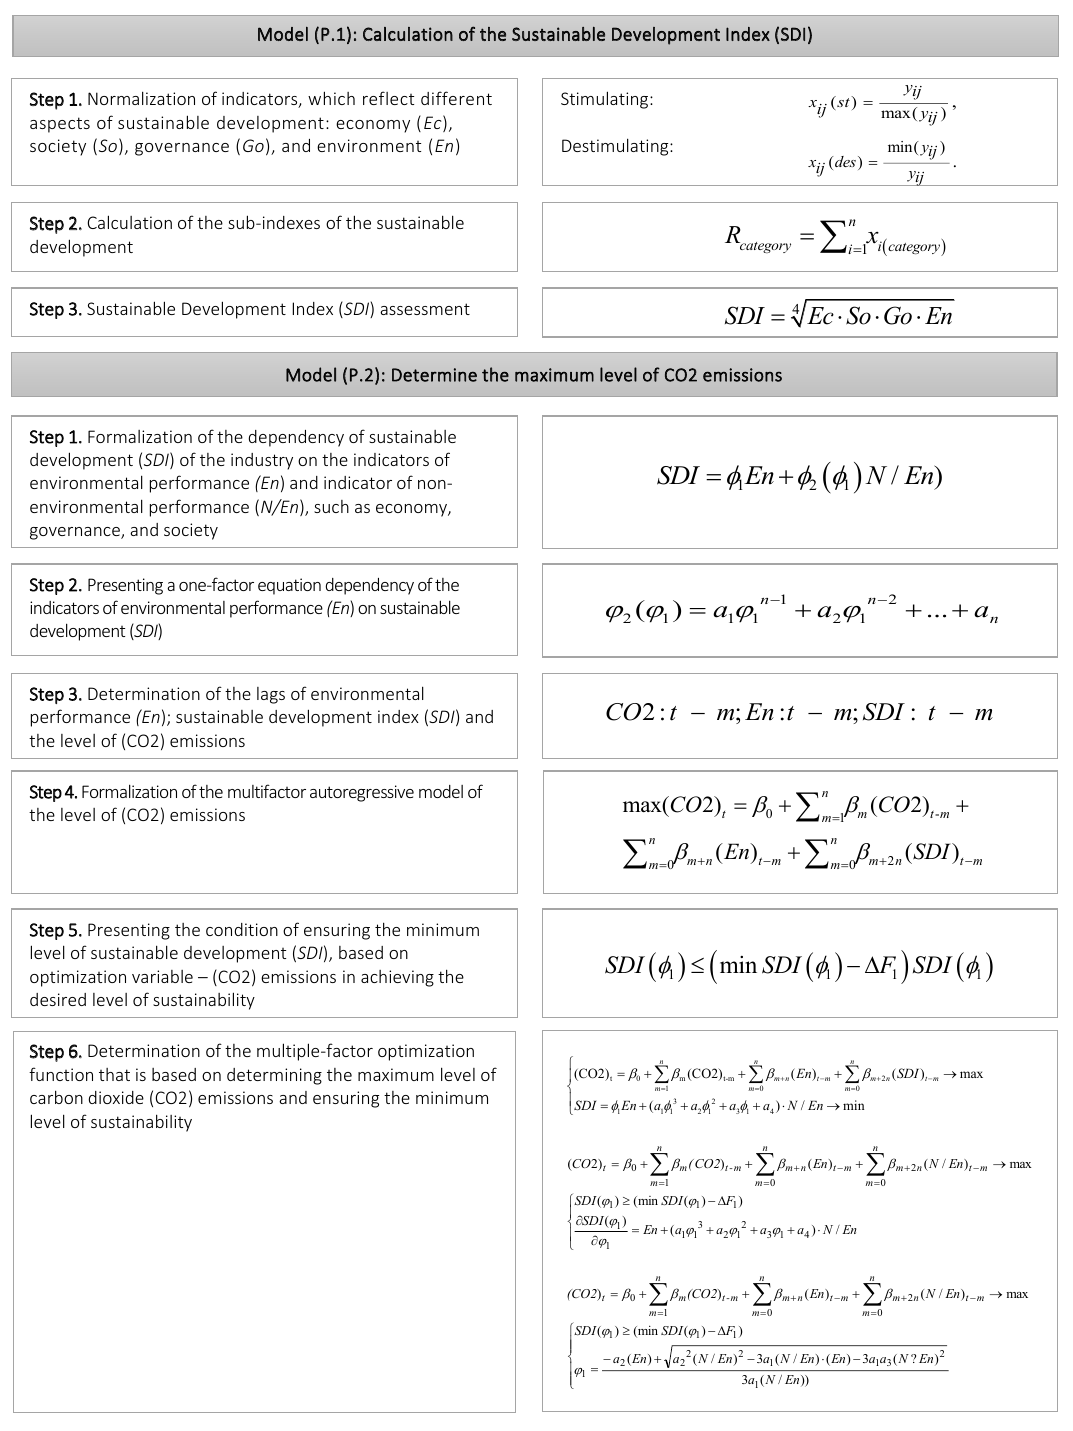
Figure 3. Mathematical model for determining the maximum level of CO2